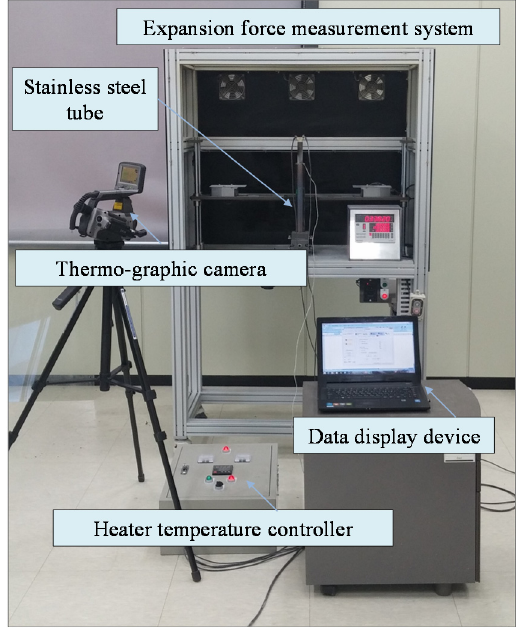
Figure 3. Instrumentation of laboratory equipment.